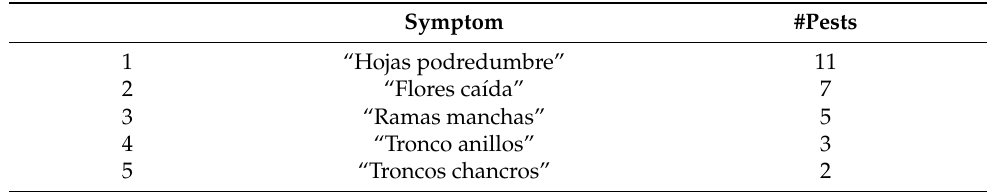
Table 3. Symptoms and number of associated pests (partially in